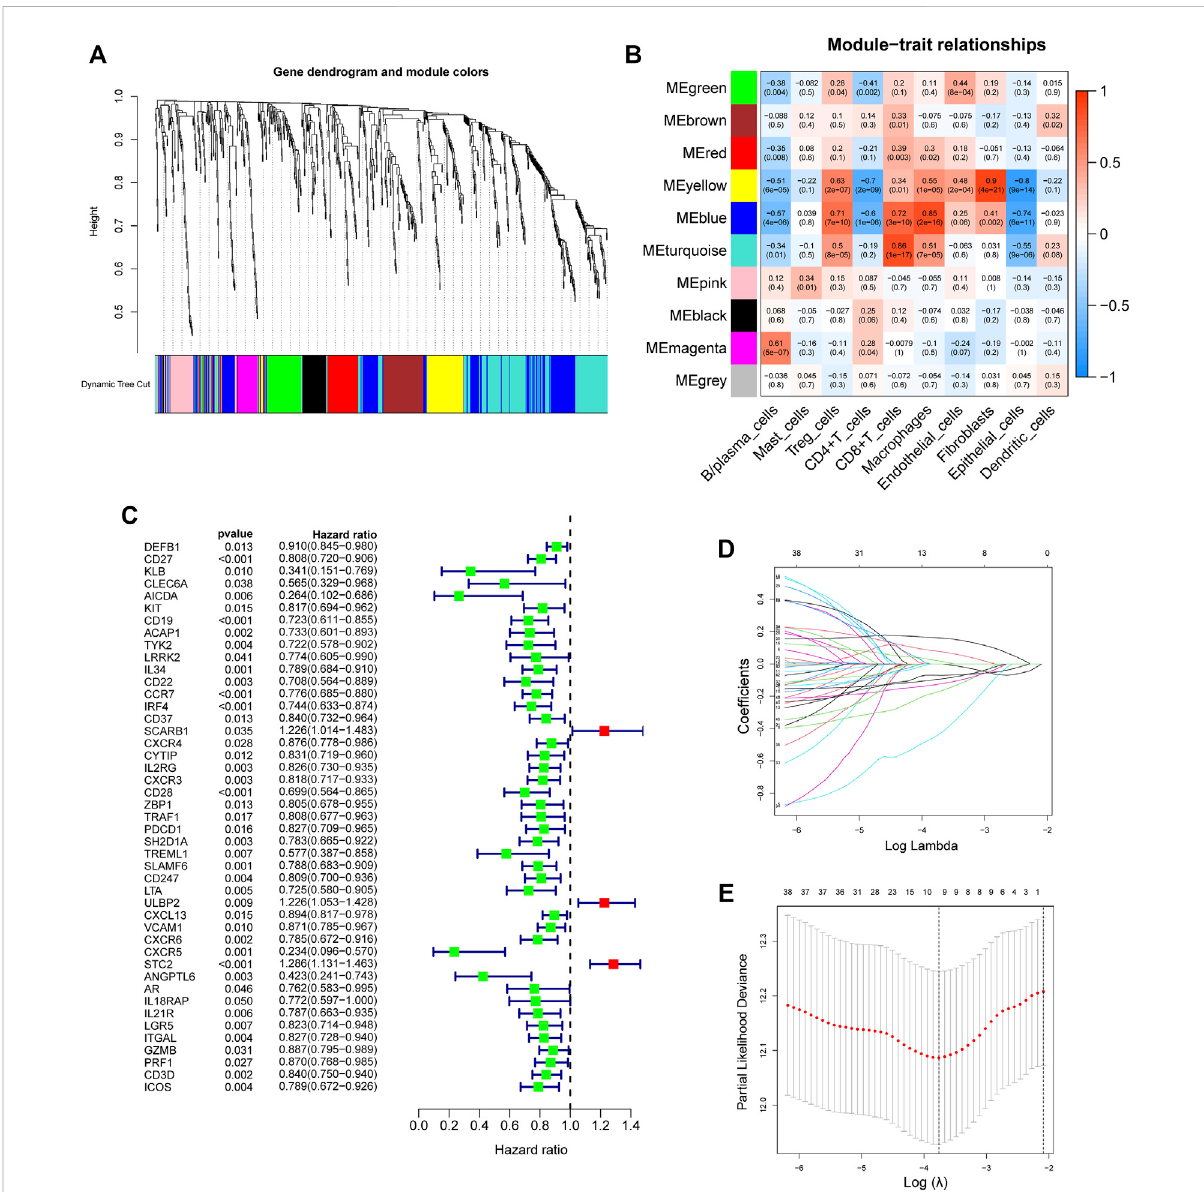
FIGURE 5 Development of an 8-gene signature. (A) The Cluster dendrogram of co-expression network modules obtained by WGCNA. (B) Correlation heatmapamongtenco-expressionmodulesandthelevelsofcellsubtypes.TheturquoisemodulehadthegreatestcorrelationwithCD8 +